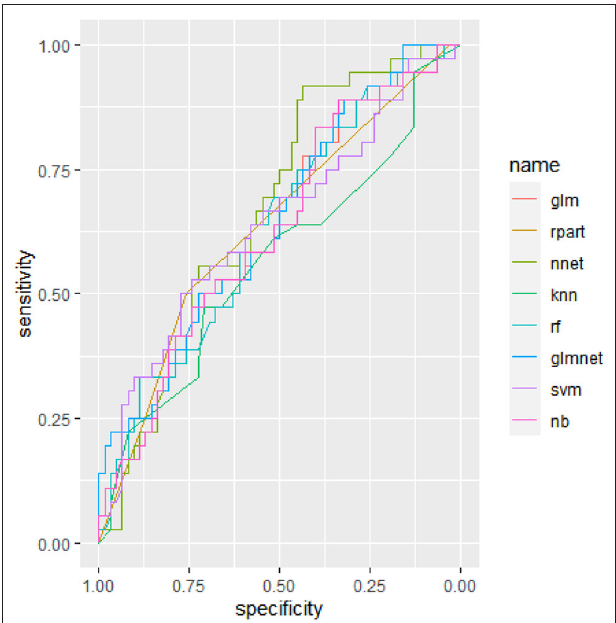
FIGURE 2 | Comparison of performance of eight ML algorithms in testing